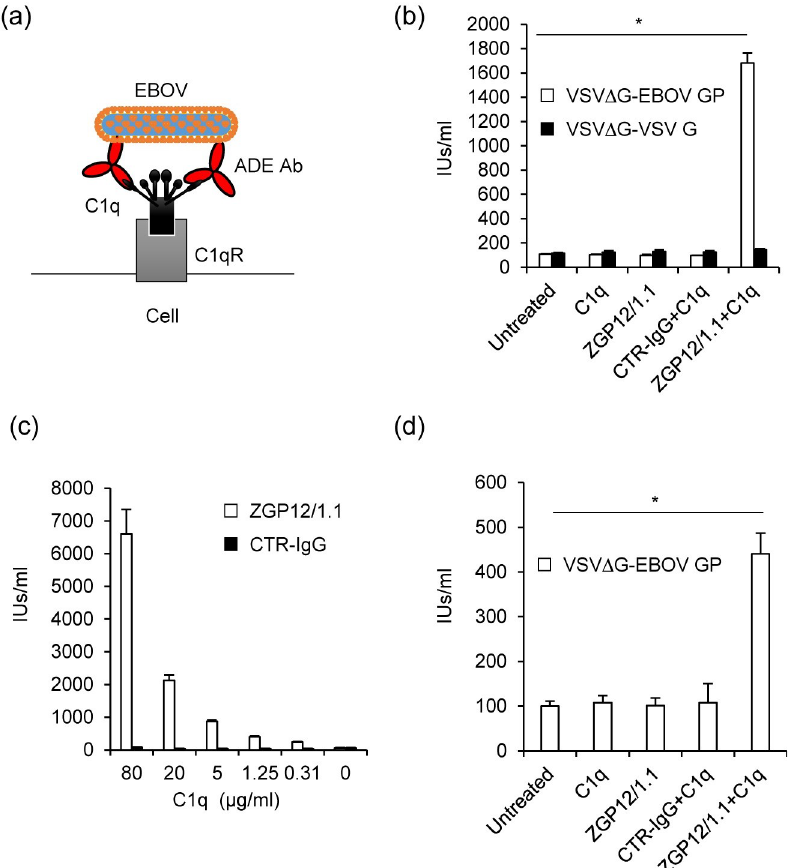
Fig 1. C1q-mediated ADE of EBOV GP-mediated infection. (a) Schematic representation of C1q-mediated ADE. (b) HEK293 cells were infected with VSV Δ G-EBOV GP or VSV Δ G-VSV G pretreated with C1q (20 μ g/ml), ZGP12/1.1 (1 μ g/ml), or combination of C1q (20 μ g/ml) and either CTR-IgG (1 μ g/ml) or ZGP12/1.1 (1 μ g/ml). (c) VSV Δ G-EBOV GP was incubated with ZGP12/1.1 (1 μ g/ml) or CTR-IgG (1 μ g/ml) together with the indicated concentrations of C1q and inoculated to HEK293 cells. (d) Vero E6 cells were infected with VSV Δ G-EBOV GP pretreated with C1q (20 μ g/ml), ZGP12/1.1 (1 μ g/ml), or a combination of C1q (20 μ g/ml) and either CTR-IgG (1 μ g/ ml) or ZGP12/1.1 (1 μ g/ml). Virus titers were determined as IUs by counting GFP-positive cells. The mean and standard deviation of three independent experiments are shown. Statistical analysis was performed using Student’s t - test ( � p <